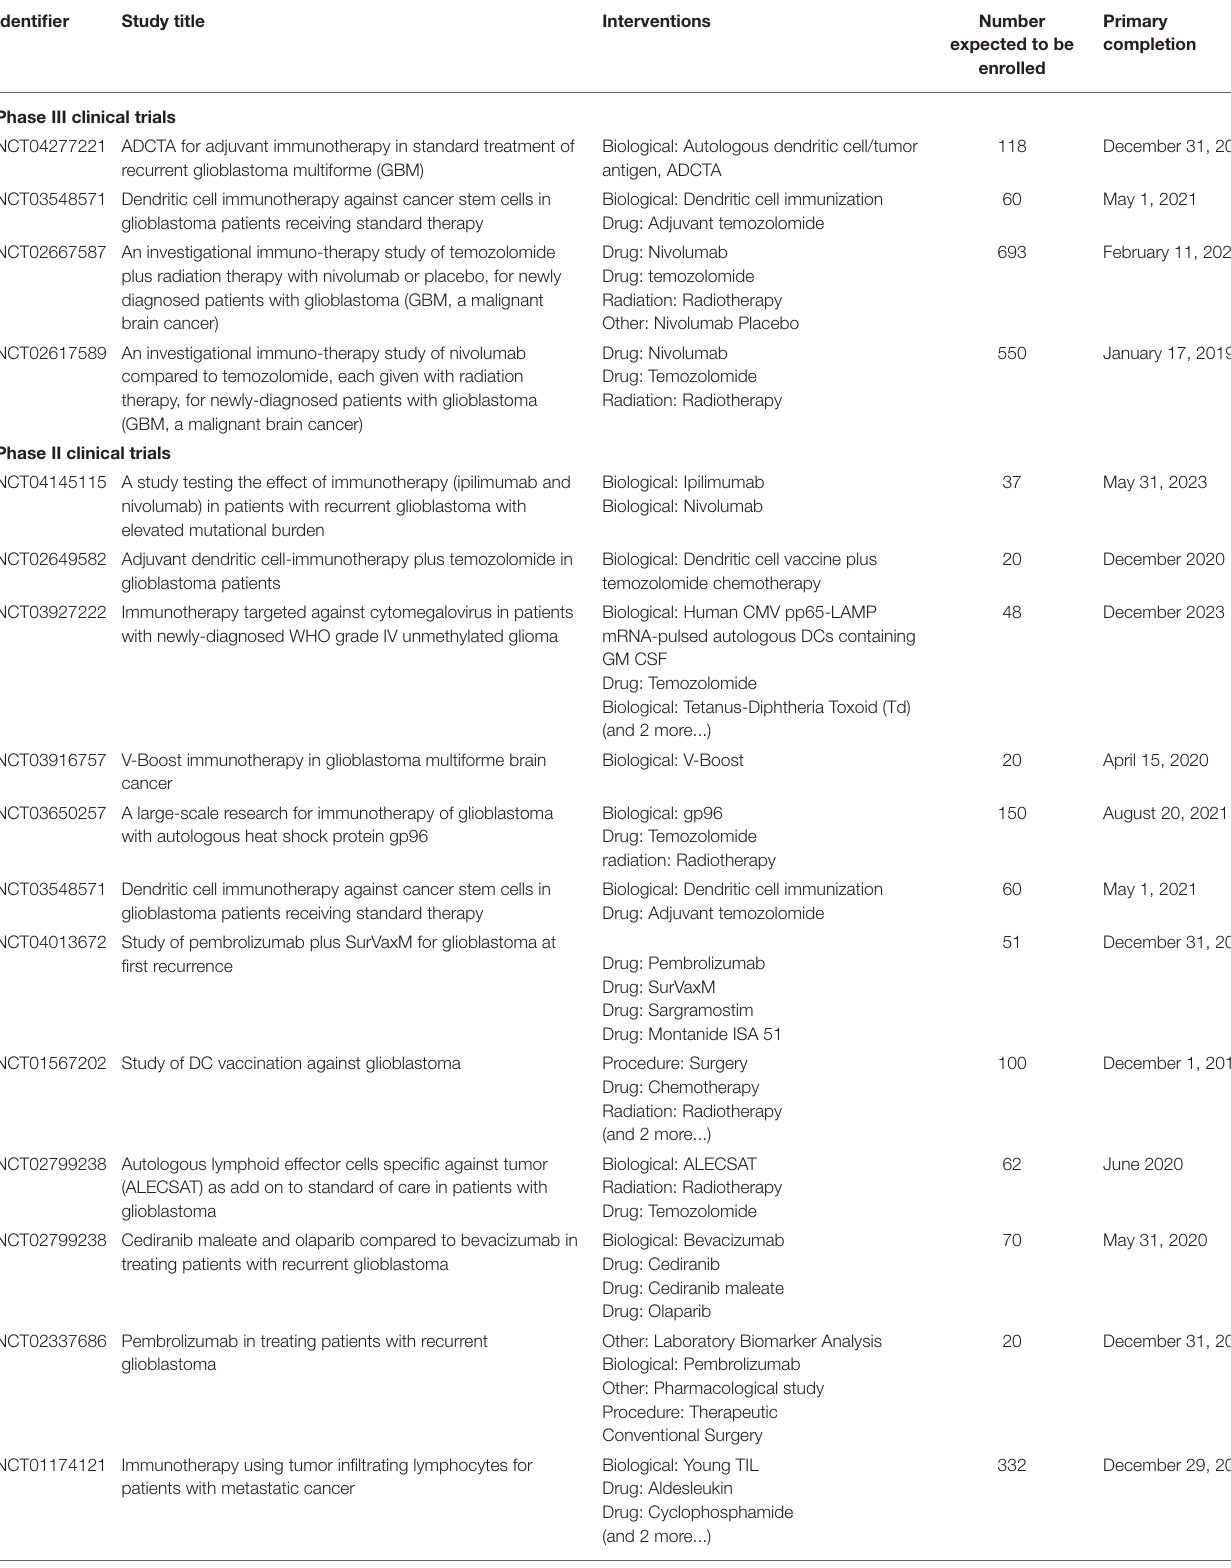
TABLE 2 | Clinical trials of immunotherapies for